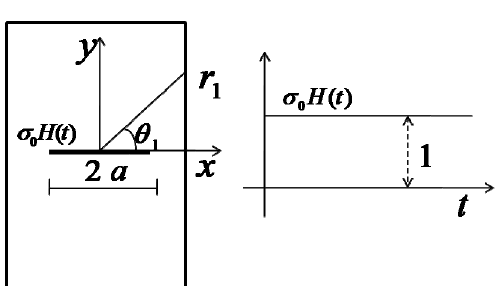
Figure 1. Crack geometry and